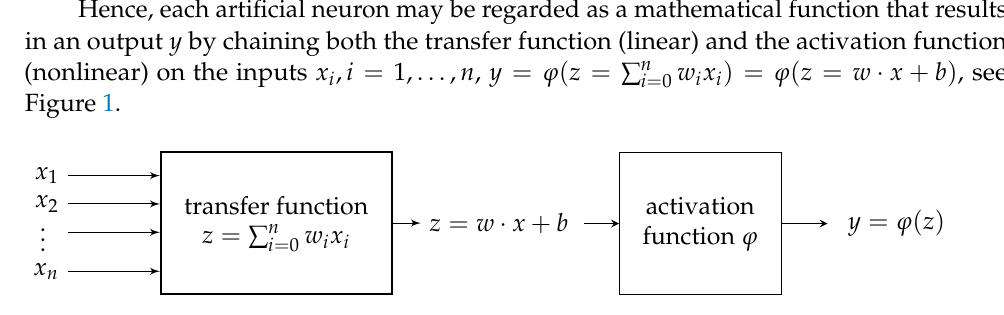
Figure 1. Single artificial neuron